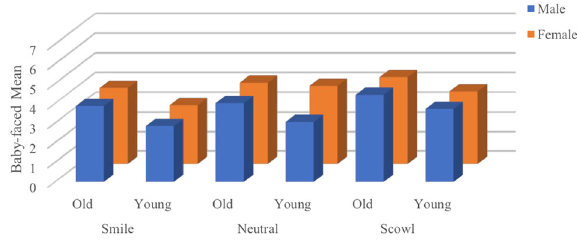
Fig. 6 Facial expression and Pleasing to Look At. This graph presents interaction of facial expression, age, and gender on mean ratings of Pleasing to Look Age and Big-Five personality traits . Univariate results revealed a signi fi cant main effect of age for Conscientiousness only, F (1, 266) = 9.37, p < 0.001, η 2 = 0.03, participants rated the young models as less Conscientious than the old models. Results